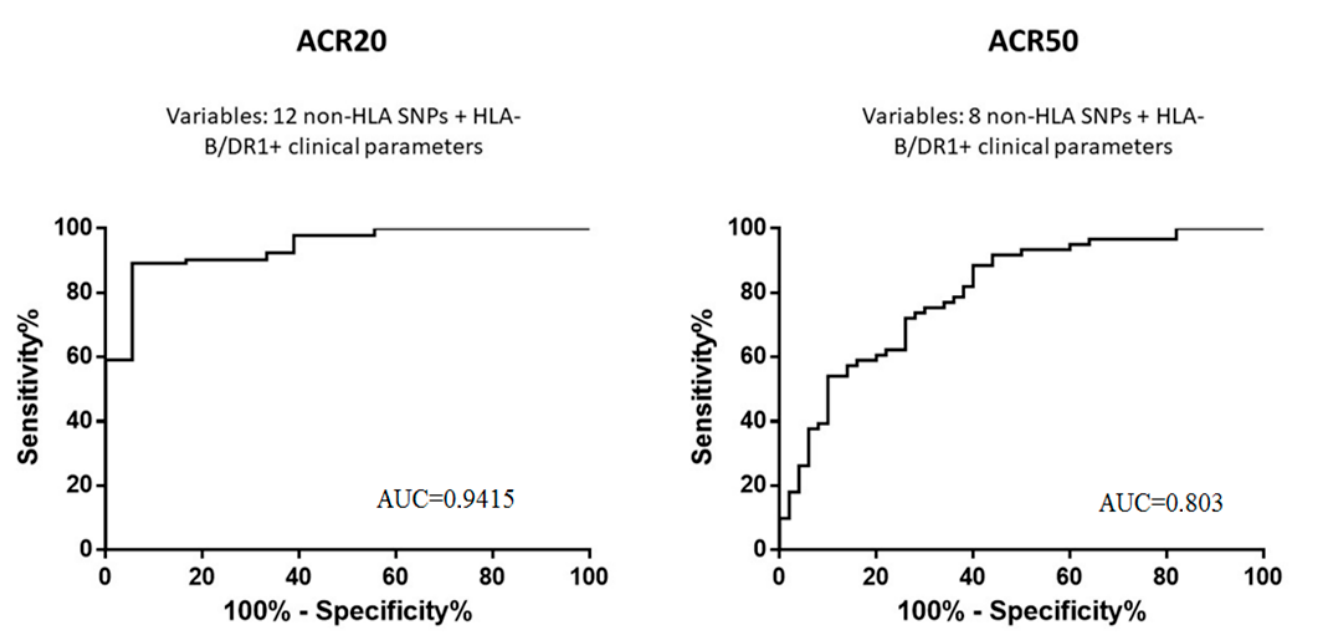
Figure 1. Predictive value of the combinations of polymorphisms and clinical factors in the response to RA therapy with olokizumab.